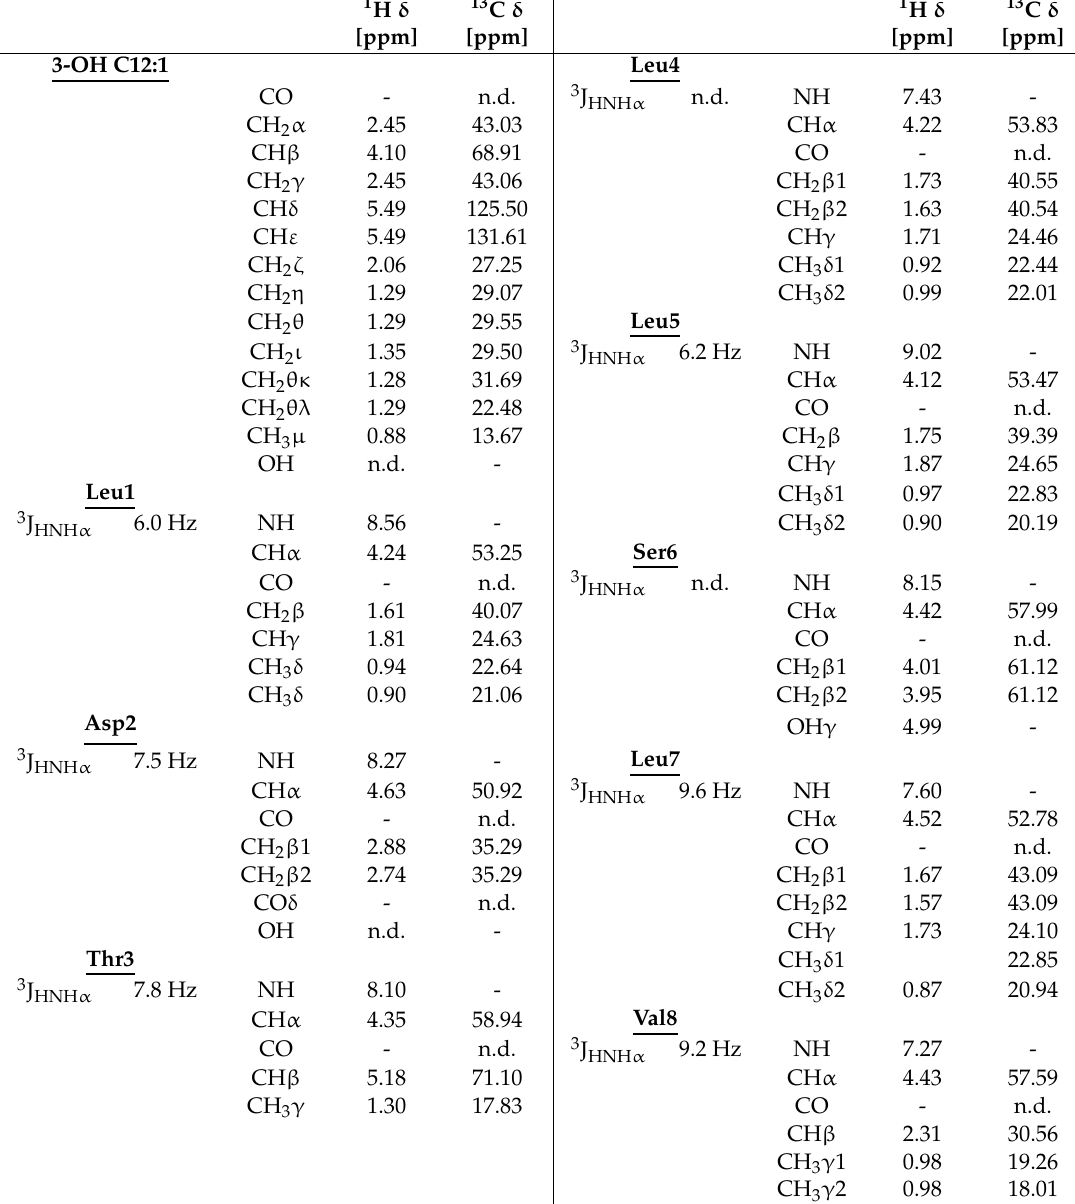
Table A4. 1 H and 13 C chemical of ‘bananamide G’ at retention time 10.9 min, in DMF-d7 (298 K, 500